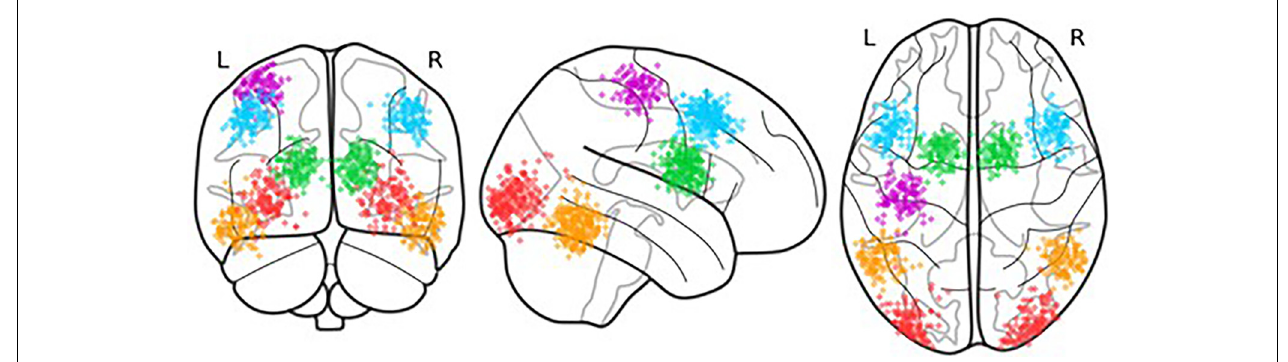
FIGURE 3 | Location of the centroids of each individual ROI. Each point represents the centroid of one ROI; variations in the centroids account for individual differences in functional